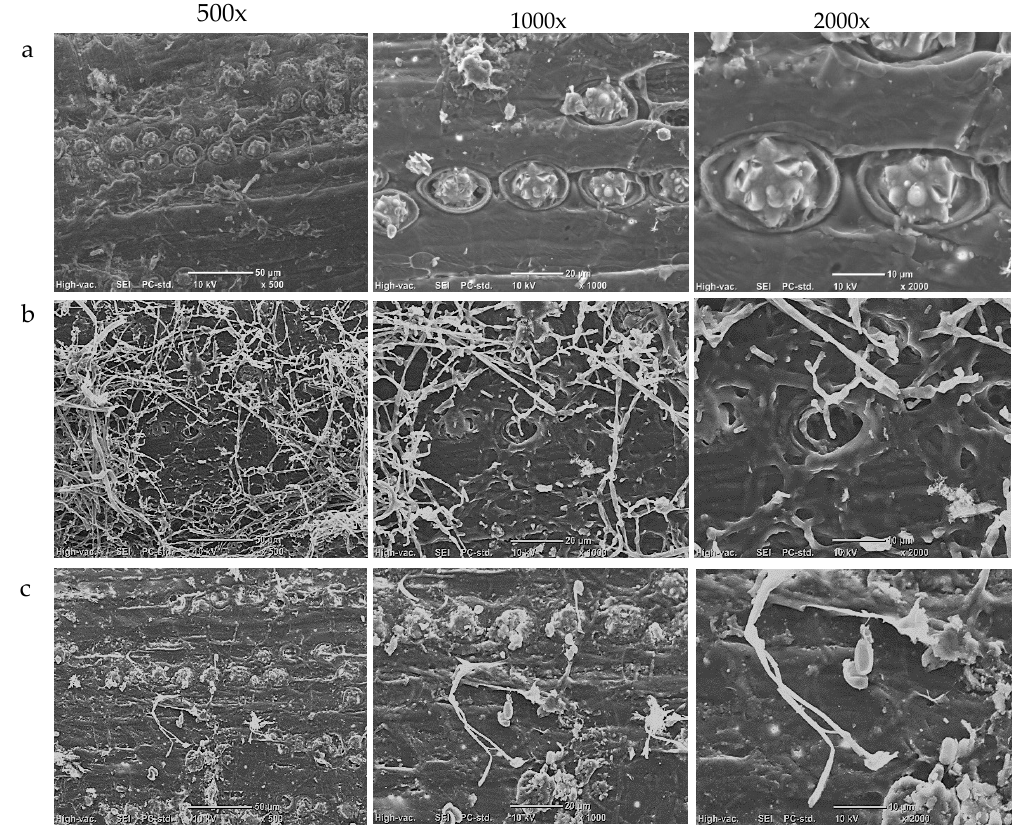
Figure 2. SEM images on the surface of OPEFB. ( a ) Untreated, ( b ) biological pretreatment with Schizophyllum commune ENN1, ( c ) biological pretreatment with Phanerochaete chrysosporium at magnification 500×, 1000× and 2000×.